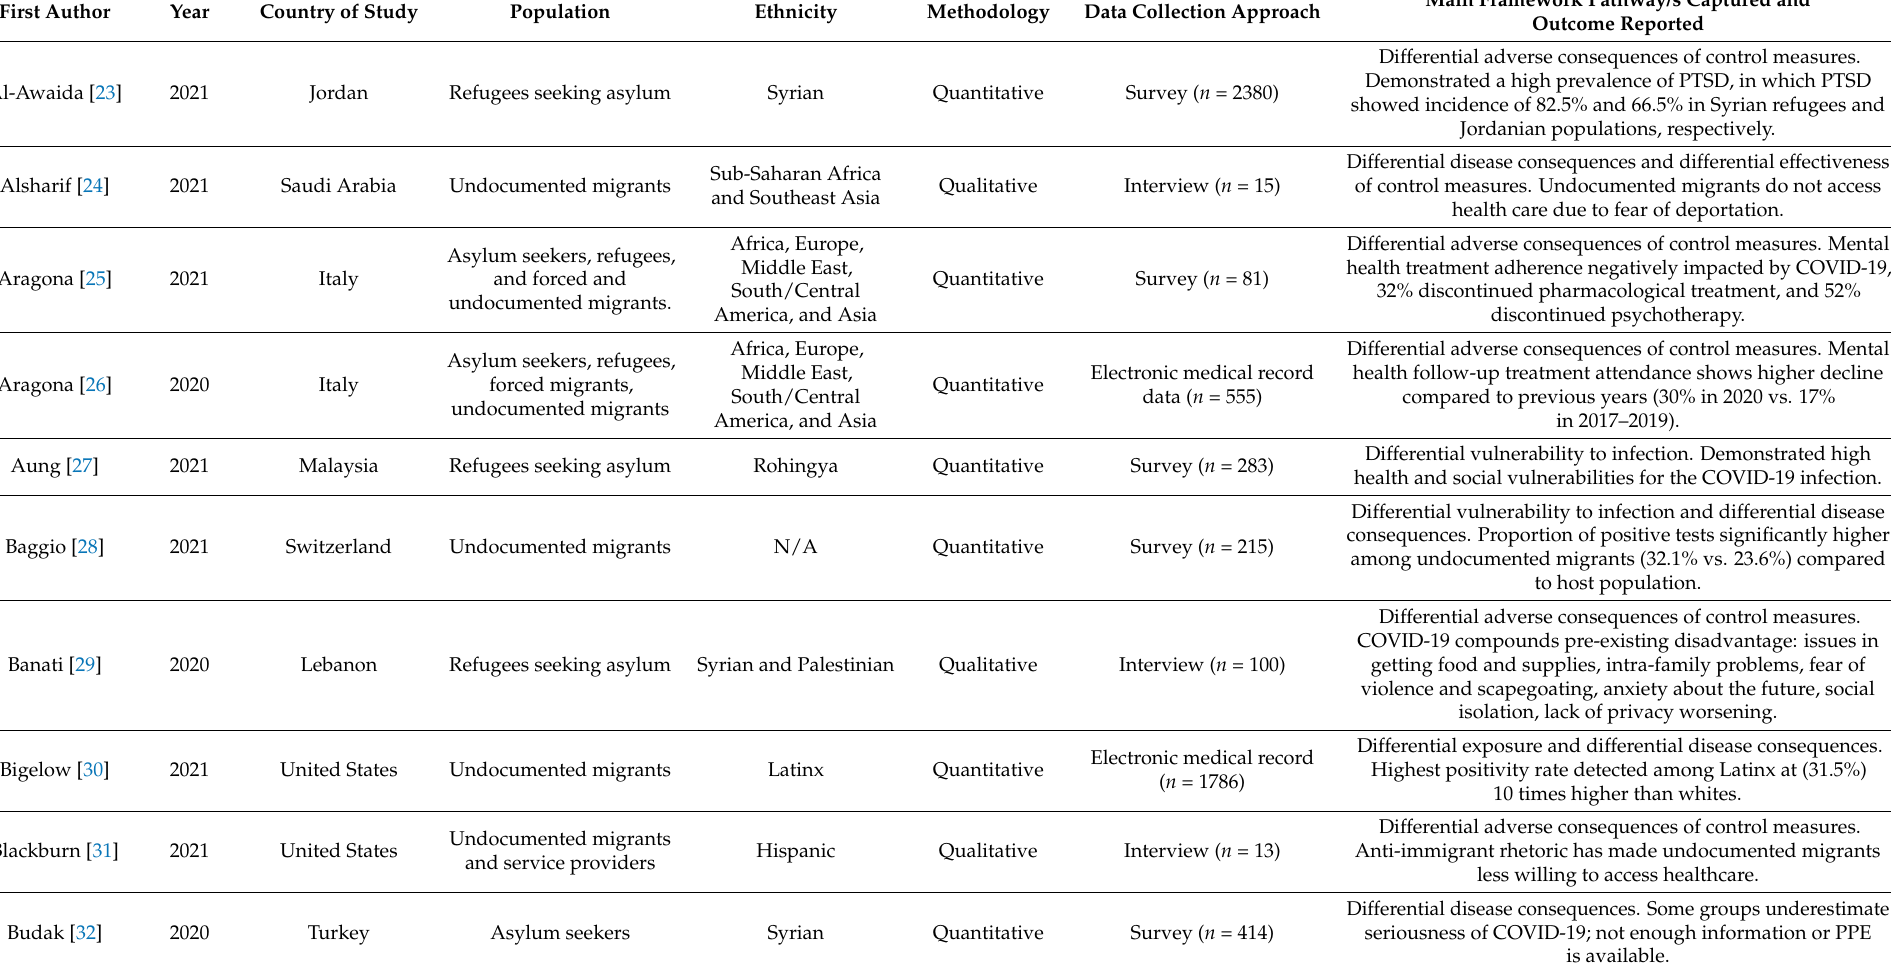
Table 2. Summary of included